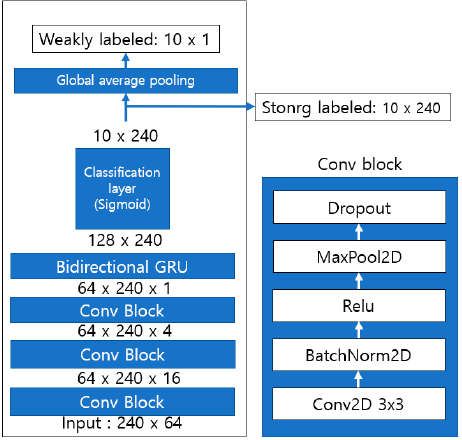
Figure 2. Structure of the basic convolutional recurrent neural network (CRNN).